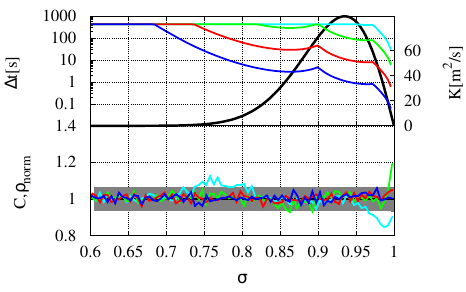
Figure 5. Dispersion experiment with different choices of param- Fig. 5. Dispersion experiment with different choices of parame- eter C T . Top panel: diffusivity profile (black line) and 1t profiles ter C T . Top panel: diffusivity profile (black line) and ∆ t profiles for C T = 0 . 5 (light blue), C T = 0 . 1 (green), C T = 0 . 01 (red) and for C T = 0 . 5 (light blue), C T = 0 . 1 (green), C T = 0 . 01 (red) and C T = 0 . 001 (blue). Bottom panel: normalized concentration pro- C T = 0 . 001 (blue). Bottom panel: normalised concentration pro- files for different C T (Line colors as in the top panel). files for different C T (line colours as in the top panel). Table 1. RMSE and execution time for different C T .